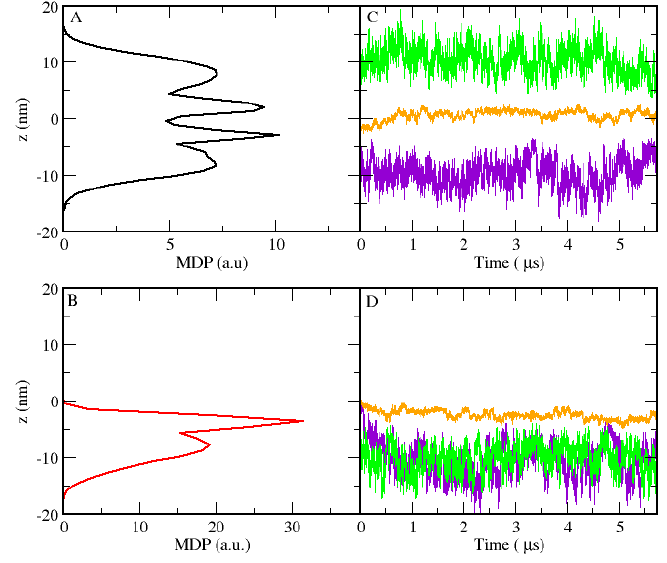
Figure 6. MDPs of a single polymer in the LS ( A ) and LU ( B ) cases, as functions of the z coordinate (rotated). Trajectories of the terminal PEO beads (green and violet) and the central PPO bead (orange) as functions of time for the same polymer of LS ( C ) and LU ( D ).